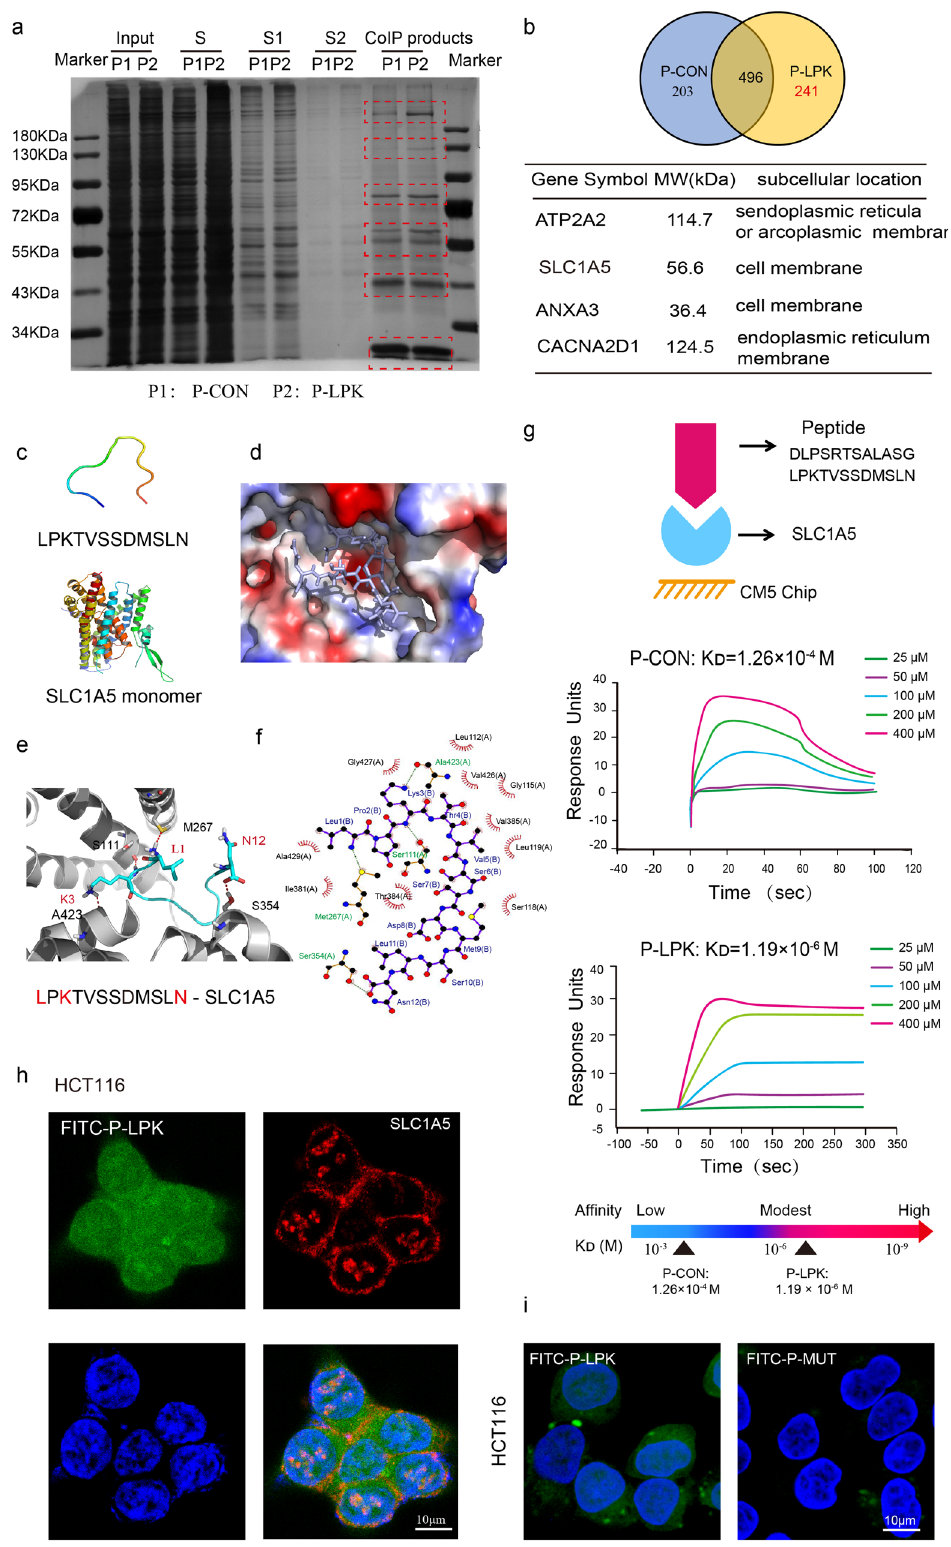
immobilized to the chip surface CM5. A representative sensor- gram of peptide binding to the recombinant SLC1A5 was shown in Fig. 5g. The P-LPK peptide displayed a moderate binding af fi nity to SLC1A5, which was 100-fold compared to the control P-CON peptide (K D of ∼ 1.19 × 10 − 6 vs. ∼ 1.26 × 10 − 4 M).